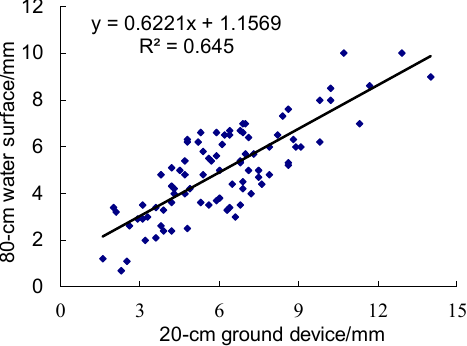
Figure 6. Comparison and correlation between the observed values at the 80-cm lake-surface and the 20-cm ground-evaporation measurements.